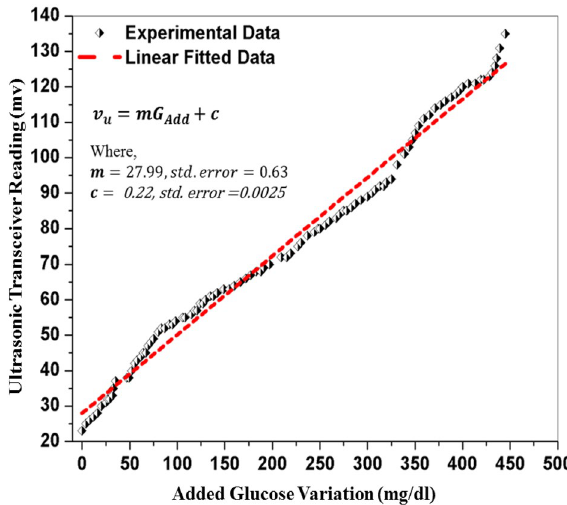
Figure 3. The variation in the receiving ultrasonic transceiver readings due to the fluctuation in blood glucose level.